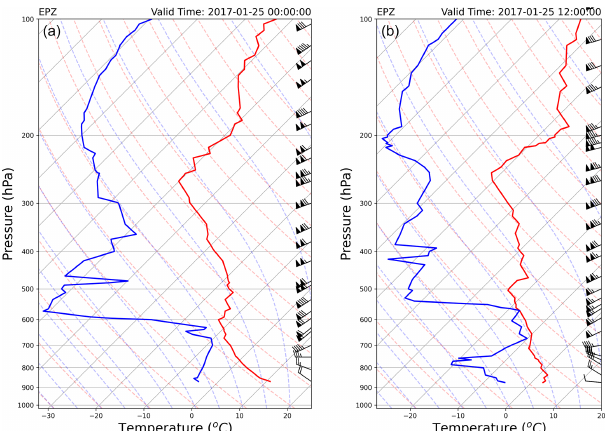
Figure 3. Skew- T plot for 25 January 2017, at 00:00UTC (a) and 12:00UTC (b) , of the radiosonde data from the NWS, Santa Teresa, New Mexico. The dew point temperature T d is indicated with blue line, and temperature T is indicated with red line. The wind barbs on the right side of each skew- T plot provide wind speed and direction at the corresponding air pressure and